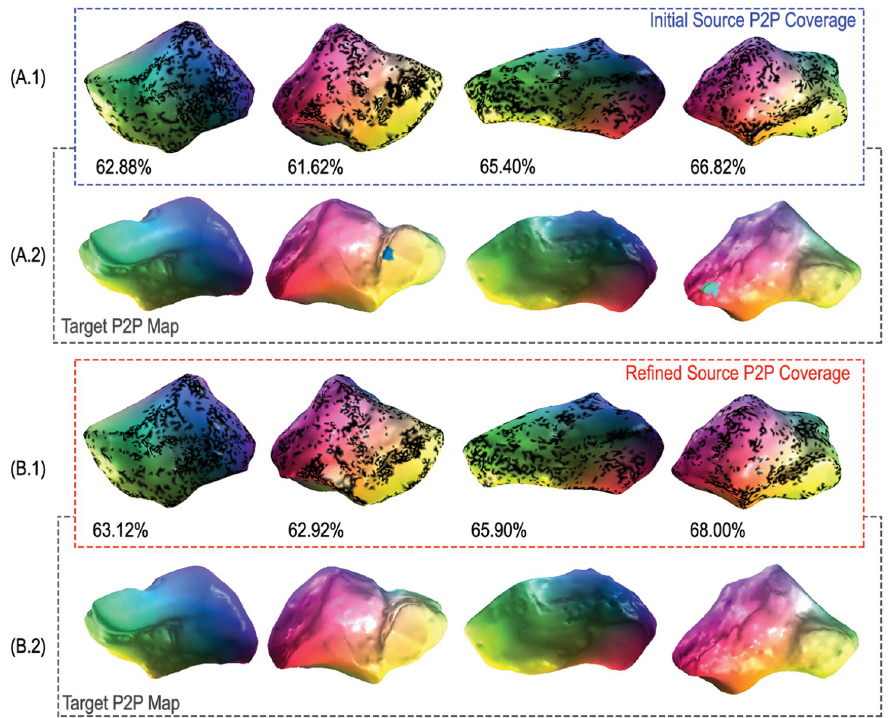
Fig 4. Estimating and improving hominoid medial cuneiform correspondences. We compare maps generated by HSN ResUNet descriptor learning model to their Consistent ZoomOut-refined counterparts for four randomly chosen pairs of hominoid